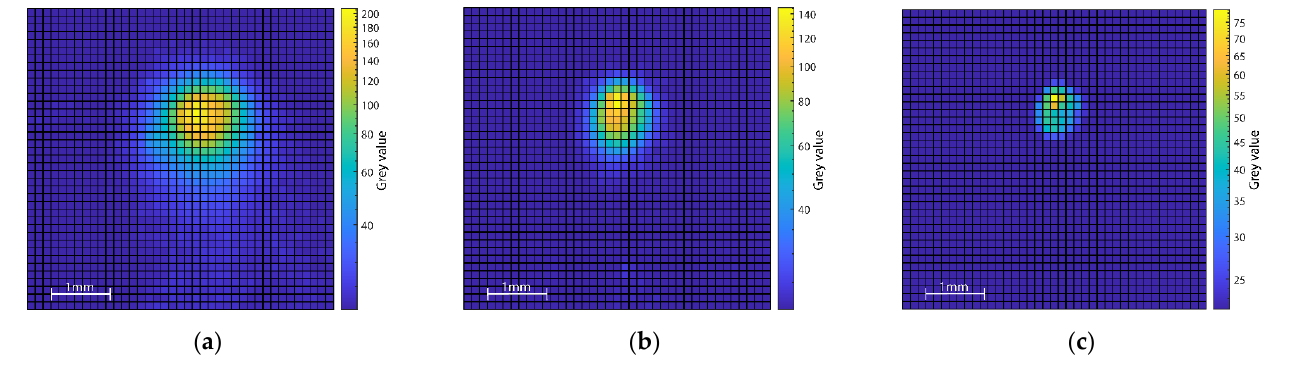
Figure 7. IR-images for ( a ) 460 W, 0.05 m/s; ( b ) 240 W, 0,5 m/s; ( c ) 105 W, 1